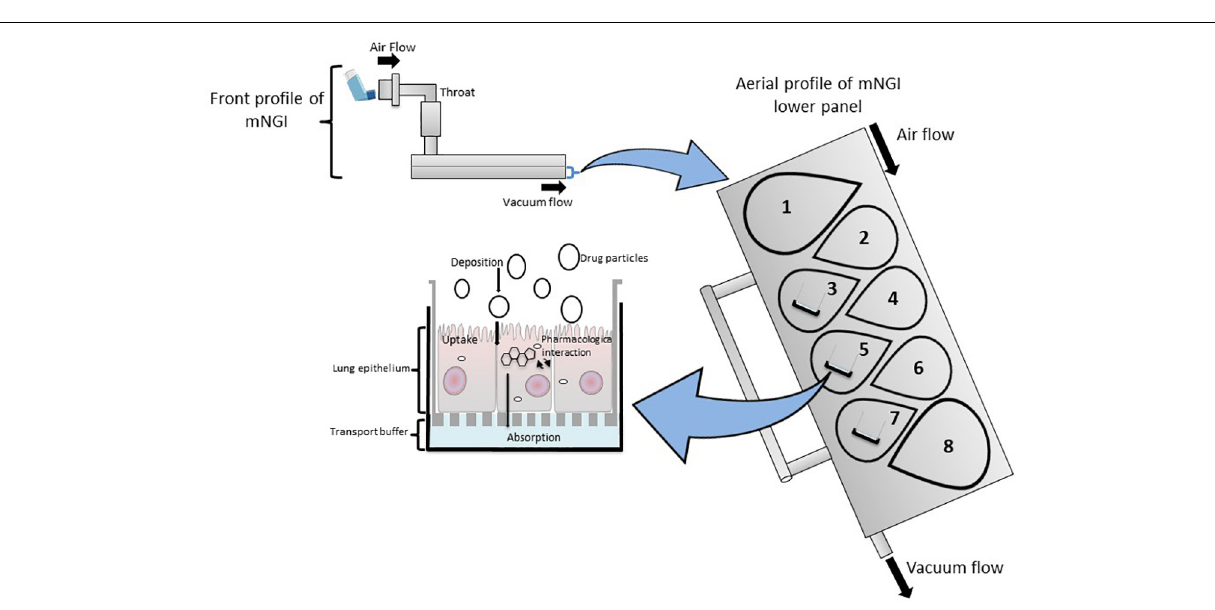
FIGURE 4 | A modified Next Generation Impactor (mNGI) with the implementation of Transwell inserts embedded with respiratory cells on stages 3, 5, and 7 at the lower panel of the apparatus. Airflow is maintained at a controlled flow rate and generated via vacuum flow on the opposite end of the mNGI allowing for the assessment of mouth-to-airway transit of drug particles. Evaluation of aerosolized drug particle deposition, transport and absorption across the cell epithelia is determined through assessing inserted